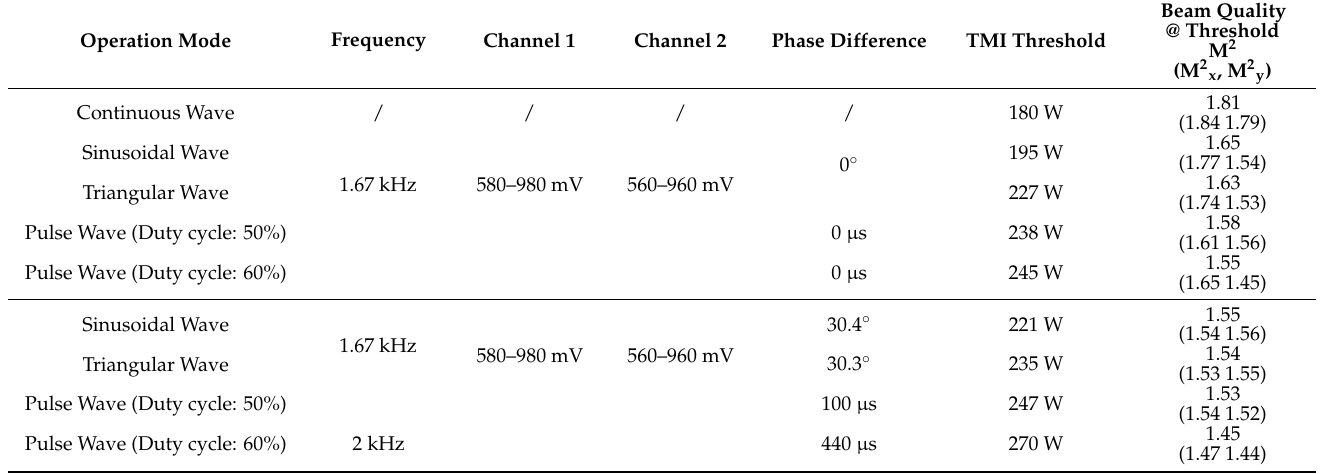
Table 1. The TMI threshold and its beam quality under CW and pump modulation based on different current